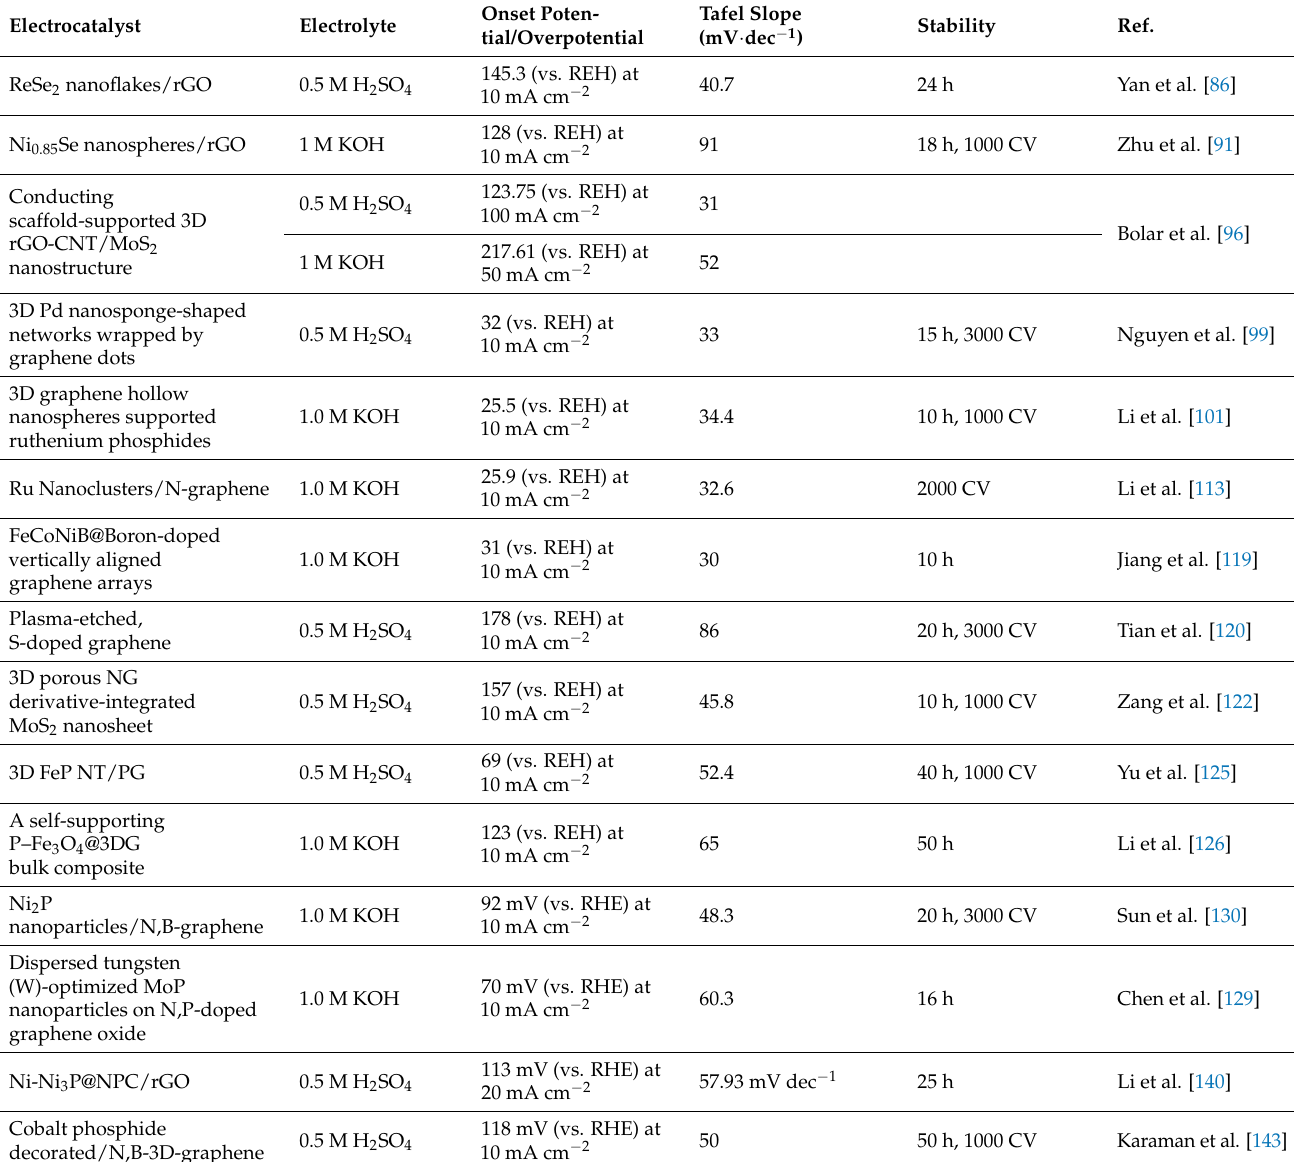
Table 1. Summary of HER performance of graphene-based